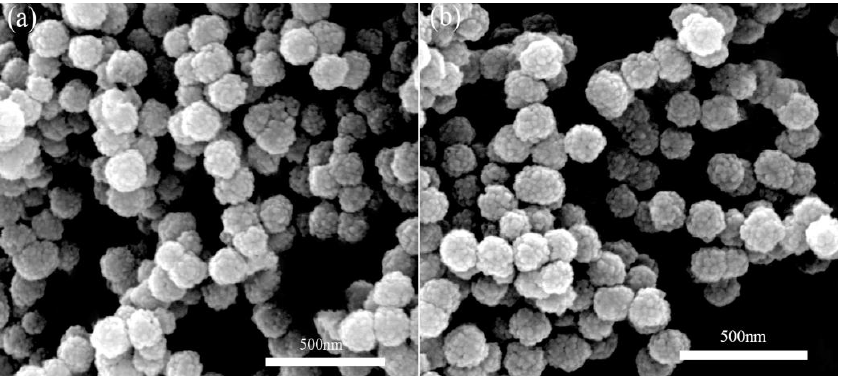
Figure 1. The SEM images of ( a ) O -Fe 3 O 4 /FePc and ( b ) E -Fe 3 O 4 /FePc.